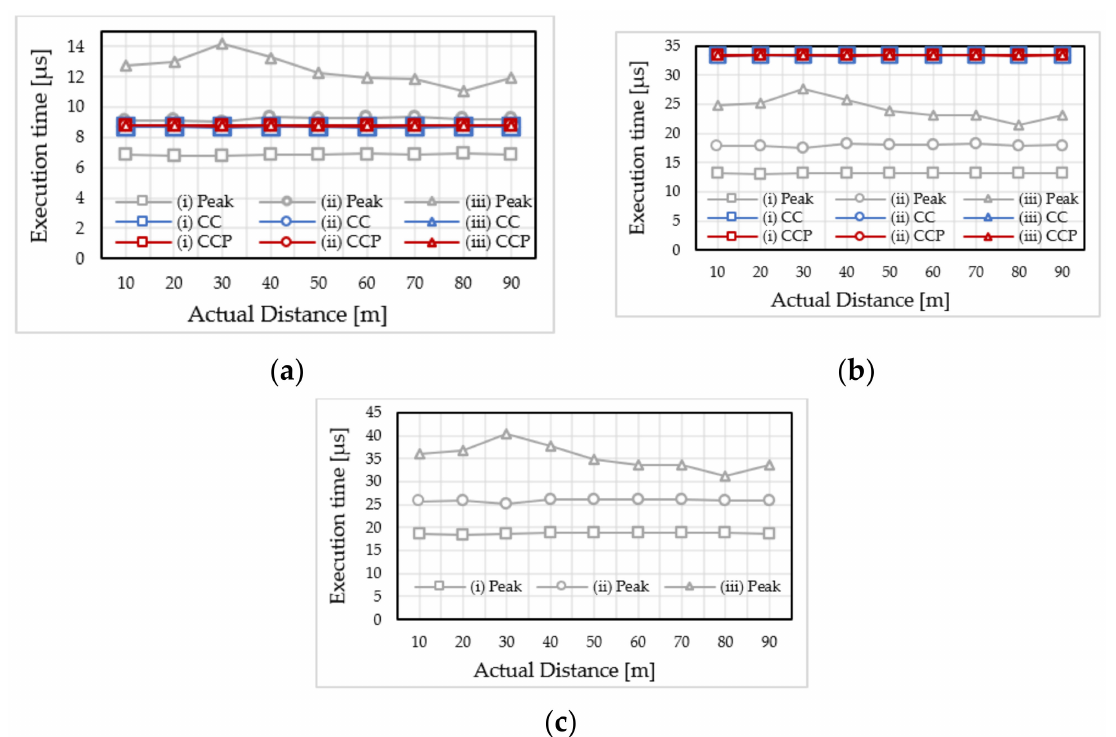
Figure 15. Execution time applied with the different number of transmitted pulses/frame: ( a ) 10 pulses/frame; ( b ) 20 pulses/frame; ( c ) 30